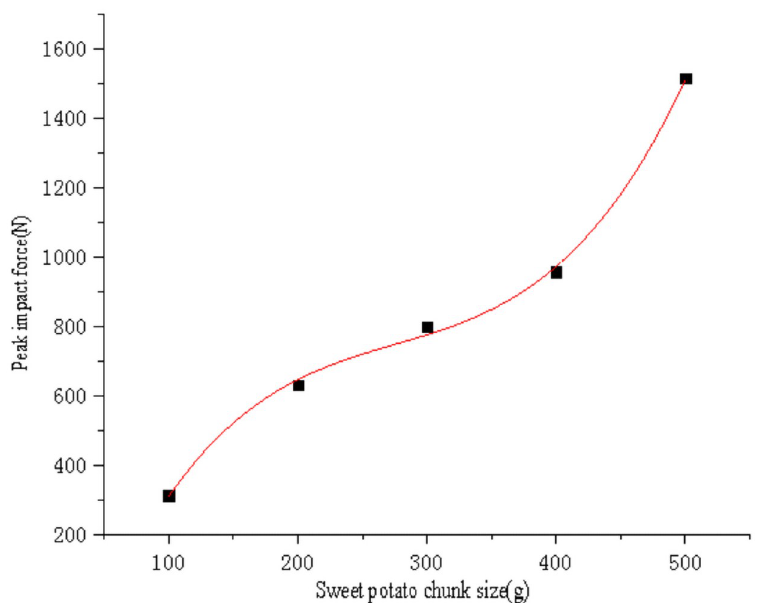
Fig 20. Fitting curve of sweet potato chunk size and impact force peak